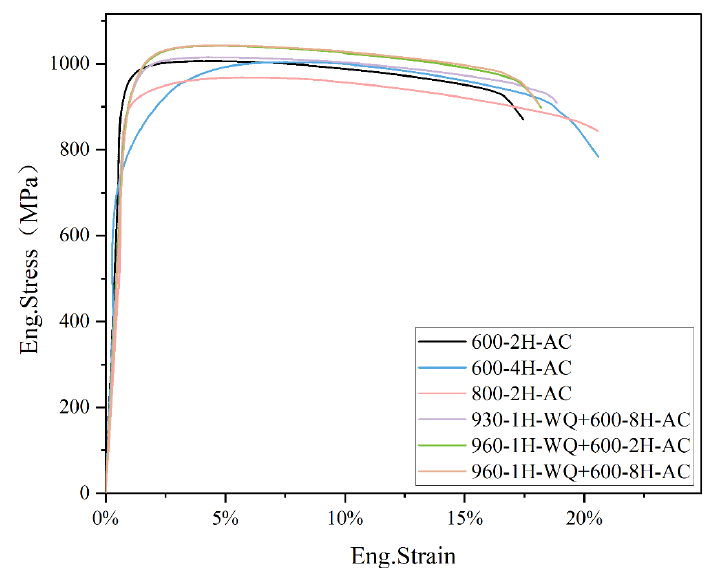
Figure 11. Tensile properties curves of SLM TC4 under different heat treatments.